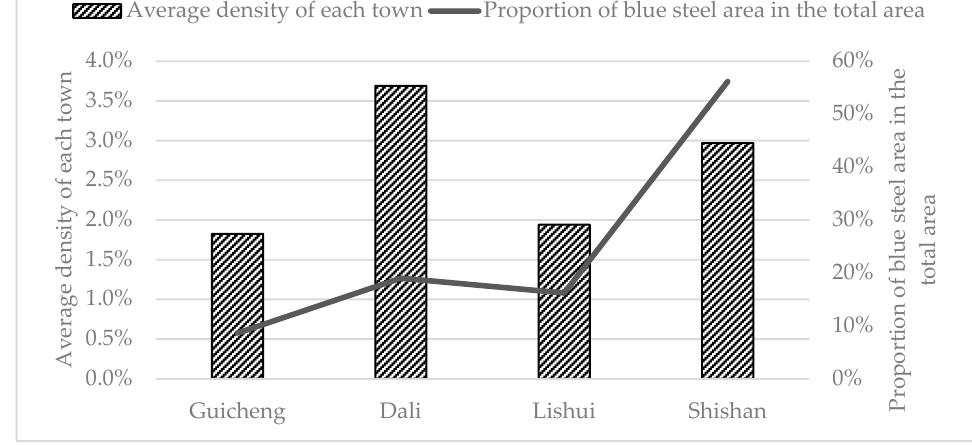
Figure 8. Proportion of blue steel roofs area out of the total area and average density.